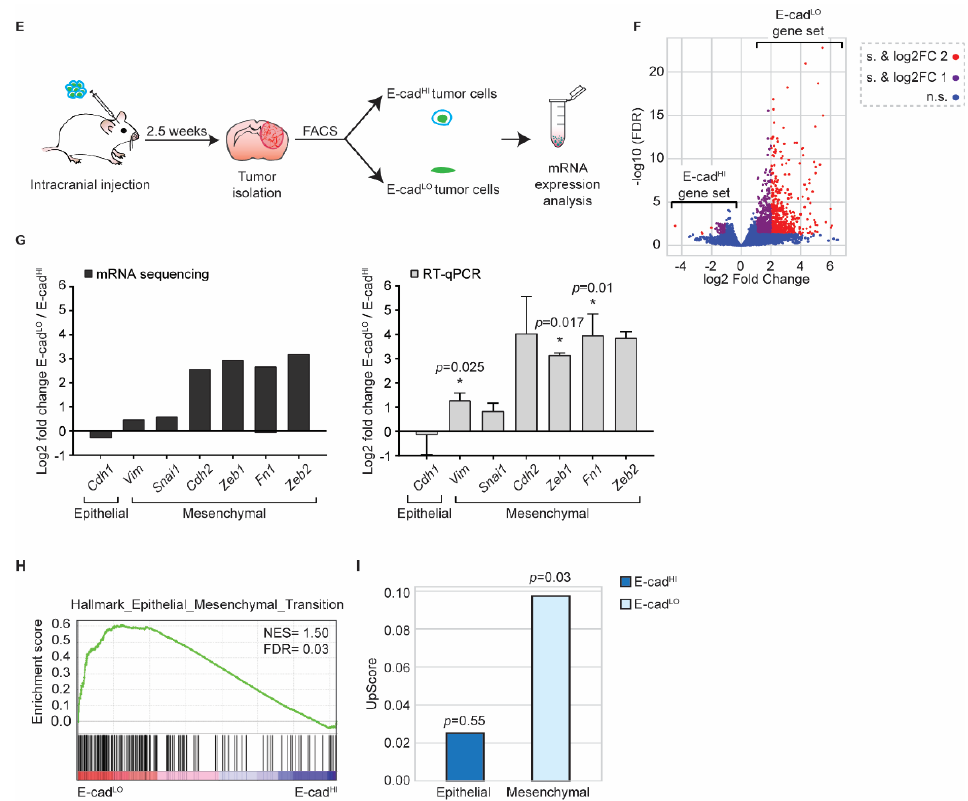
Figure 5. BCBM invading tumor cells are in a mesenchymal state. ( A ) Representative multi-photon images of BCBM tumor cells expressing H2B-Dendra2 (green) and endogenous E-cad-mCFP (turquoise). White arrowheads point to invading tumor cells. ( B ) Percentage of invading tumor cells that are E-cad LO and E-cad HI . ( C ) Representative rose plots of migratory tracks with a common origin of 20 E-cad HI tumor cells and 20 E-cad LO tumor cells imaged using multi-photon imaging through a cranial window. ( D ) Pie charts of migratory (speed ≥ 2.5 μm/h) E-cad HI or E-cad LO tumor cells. ( E ) Schematic representation of experimental design used for isolating E-cad HI or E-cad LO tumor cells for mRNA sequencing and RT-qPCR. ( F ) Volcano plot comparing the fold change and false discovery rate (FDR) of E-cad HI and E-cad LO BCBM tumor cells. ( G ) mRNA expression analysis of EMT-related genes by mRNA sequencing and RT-qPCR; n = 4 for mRNA sequencing and n = 3 for RT-qPCR with exception for Cdh2 and Zeb2, which are n = 2. Data are presented as mean +/ − SEM and standard deviation (SD) for Cdh2 and Zeb2. p -values were determined with a one-sample t -test, one-tailed between E-cad LO and E-cad HI tumor cells. ( H ) Gene set enrichment analysis [41] showing enrichment of the signature “Hallmark Epithelial_Mesenchymal_Transition” in E-cad LO BCBM tumor cells. ( I ) Upscore enrichment of E-cad HI or E-cad LO BCBM tumor cells in E-cad LO breast tumor cells [27]. Value of 0 implies that there is no enrichment of one gene set over the other. p -values were determined with a one-sample t -test to calculate the significance to